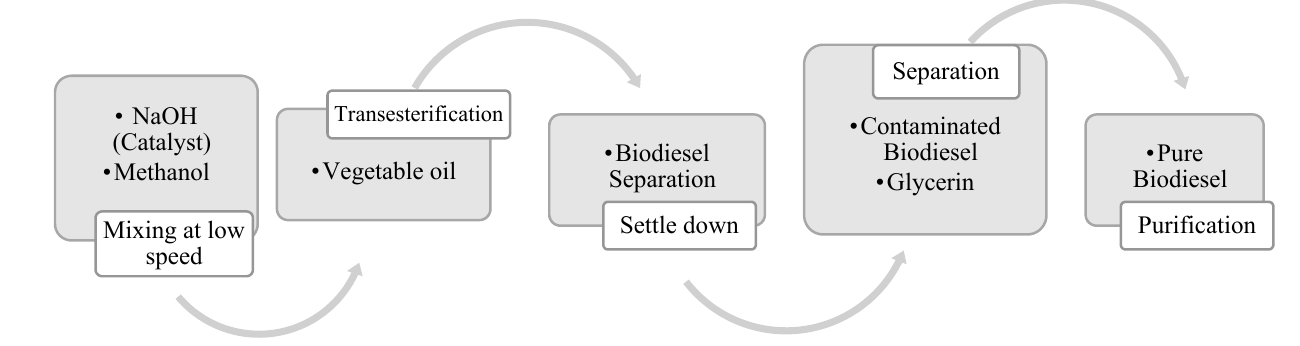
Figure 2. Production steps of vegetable oil biodiesel. Table 3. Percentage of fatty acids in oil materials used [60,64,65].